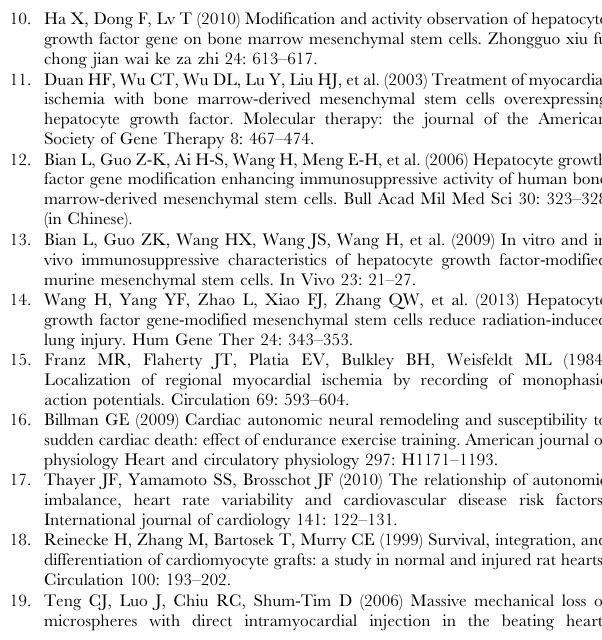
Figure S1 TUNEL analysis in the infarcted border zone. (A) HGF-MSC group. (B) PBS group. (C) MSC group. (D) Apoptotic index of different groups. TUNEL-positive nuclei were significantly decreased in the HGF-MSC group compared with other groups. * P , 0.01 vs. the PBS group; # P , 0.05 vs. the MSC